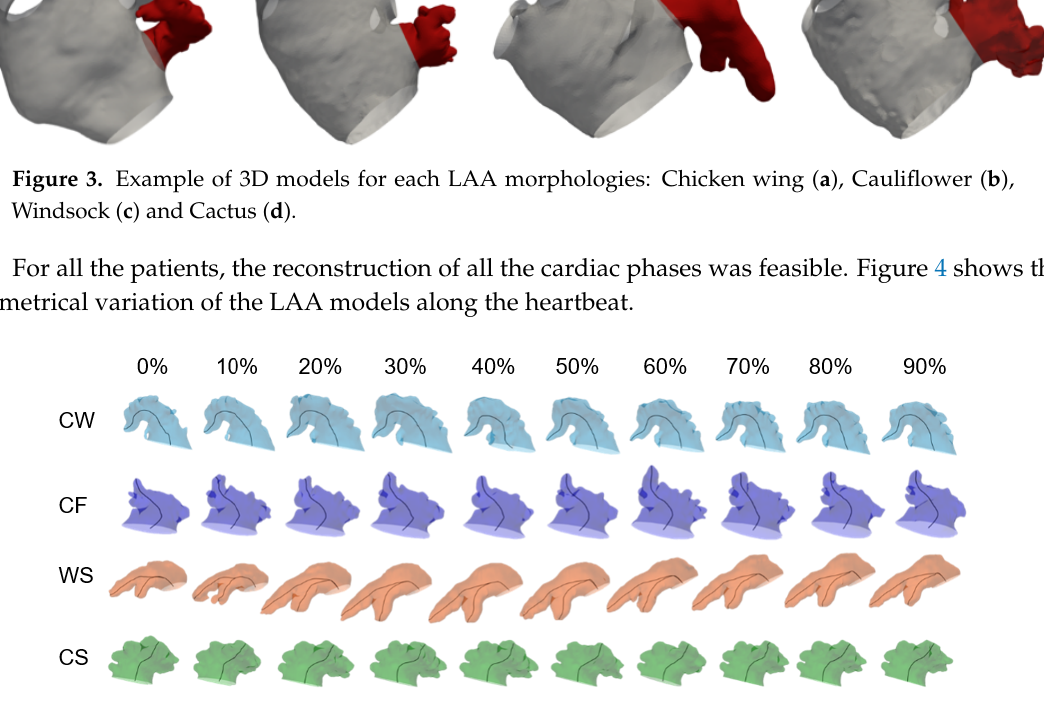
Figure 4. Shape variation over the ten phases of the cardiac cycle for all the LAA